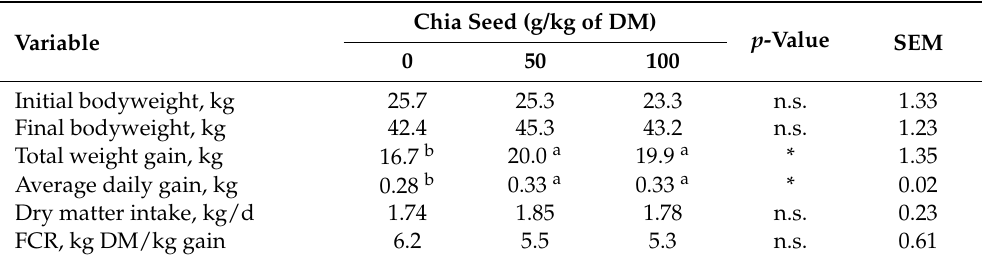
Table 2. Growth performance and feed